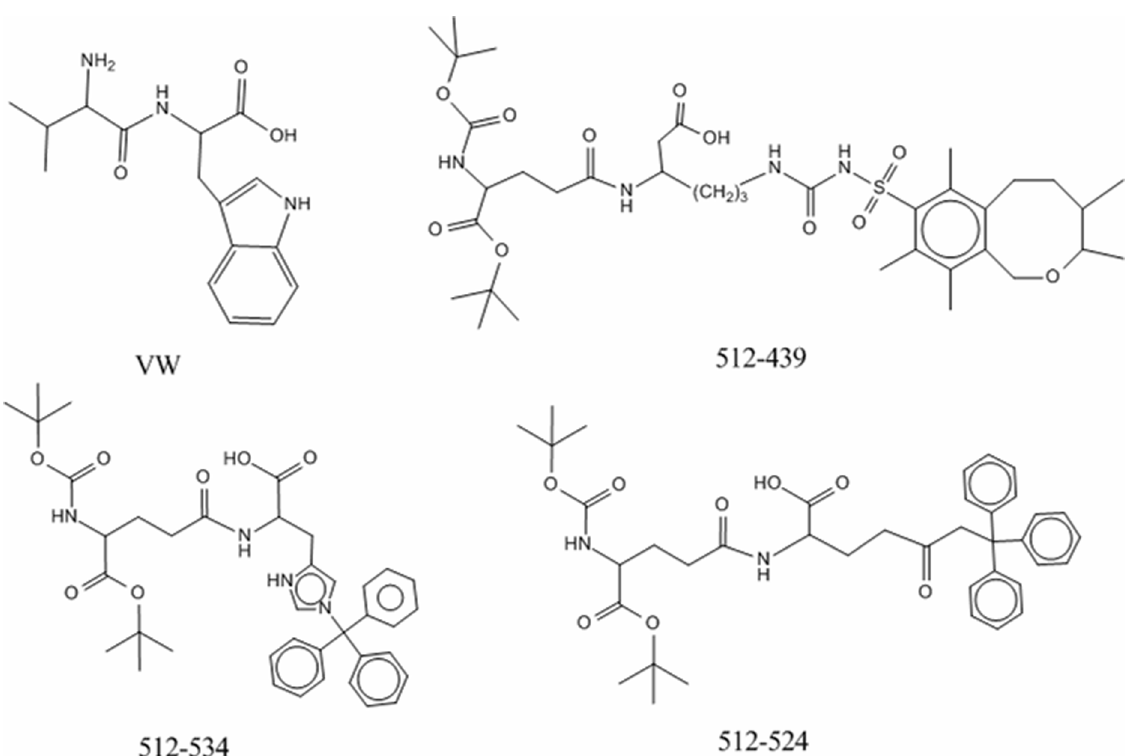
Figure 6. The newly designed peptide mimetics for ACE inhibitors. The first sample in training set, VW, is regarded as a template to design molecules. The activity of VW, 512-439, 512-534 and 512-524 is 5.80, 8.33, 8.04, and 8.04, respectively.